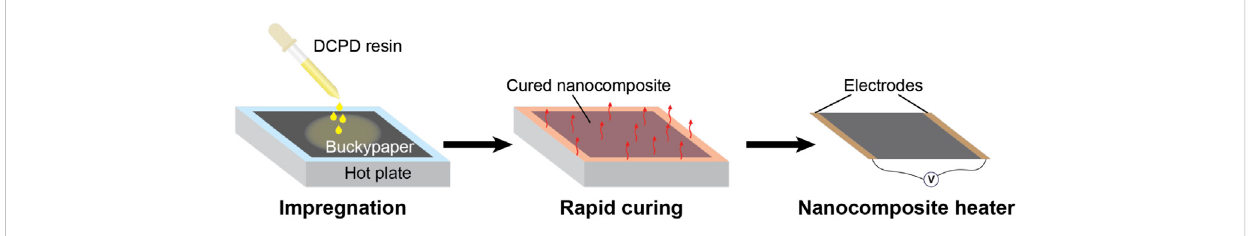
FIGURE 1 Schematic representation of the fabrication process of the nanocomposite fi lm heater. A sample of buckypaper is fi rst impregnated by the DCPD resin using droplet casting approach, followed by rapid curing via frontal polymerization. Nanocomposite fi lm heaters are then prepared by connecting two copper electrodes to the two opposite sides of the produced fi